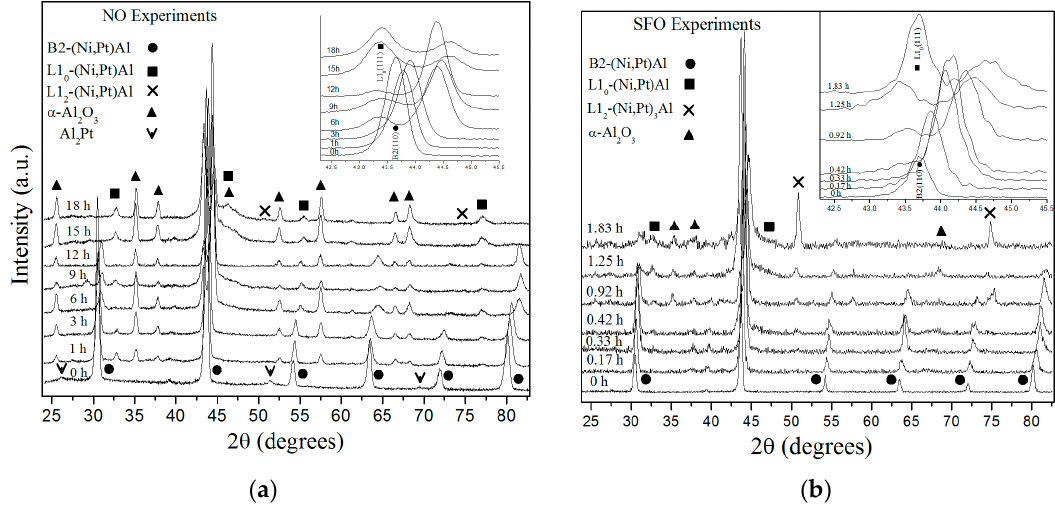
Figure 2. XRD patterns for samples processed by ( a ) natural oxidation for thermal exposure times of 0–18 h and ( b ) scale free oxidation for thermal exposure times of 0–110 min. The inset is a magnified view which better shows the evolution of the L1 0 (111) and B2 (110) peaks.